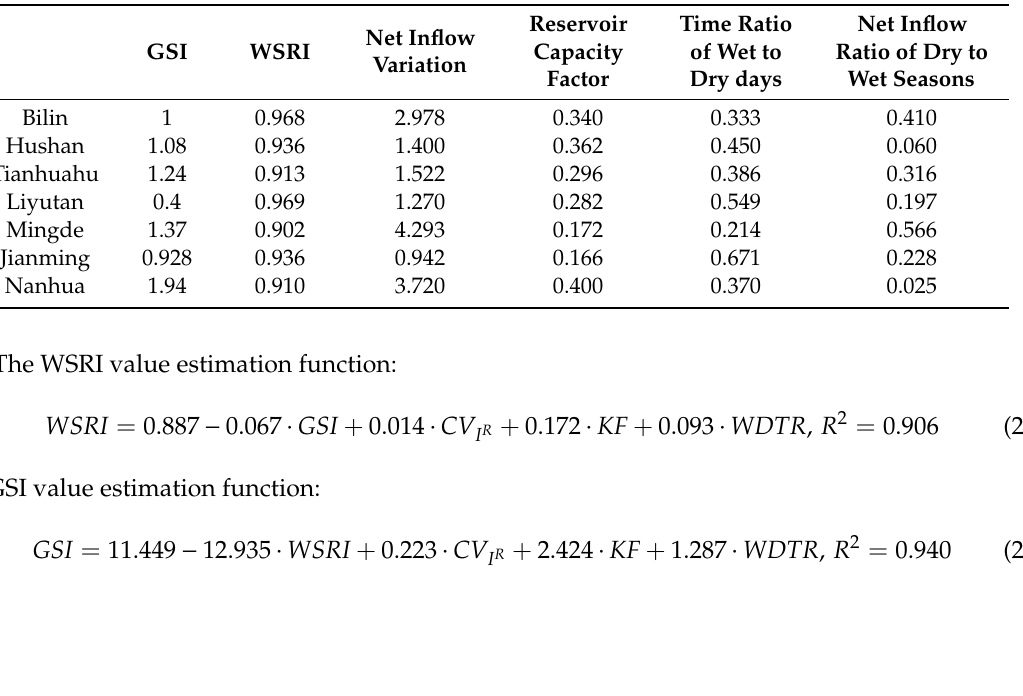
Table 10. The basic analytical data sets of seven selected reservoirs for which the planned water supply amount had been